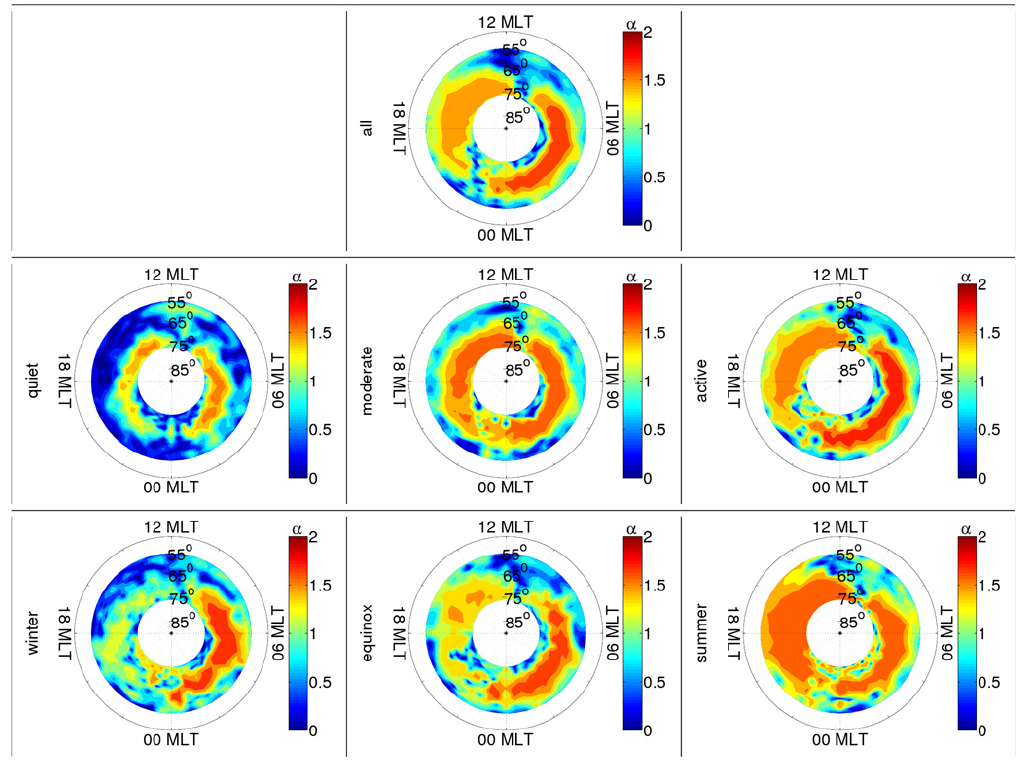
Fig. 11. Average α during 2001–2002 as a function of magnetic latitude and MLT. The resolution of the plots is 1 ◦ in latitude and 0.5h in MLT, and α is given according to the color bar on the right hand side of each plot. The upmost plot is constructed using all available data, the plots in the middle row are binned with respect to activity and those in the bottom row with respect to season (the bin is denoted on the left hand side of each plot). Reproduced from Fig. 15 of Juusola et al.